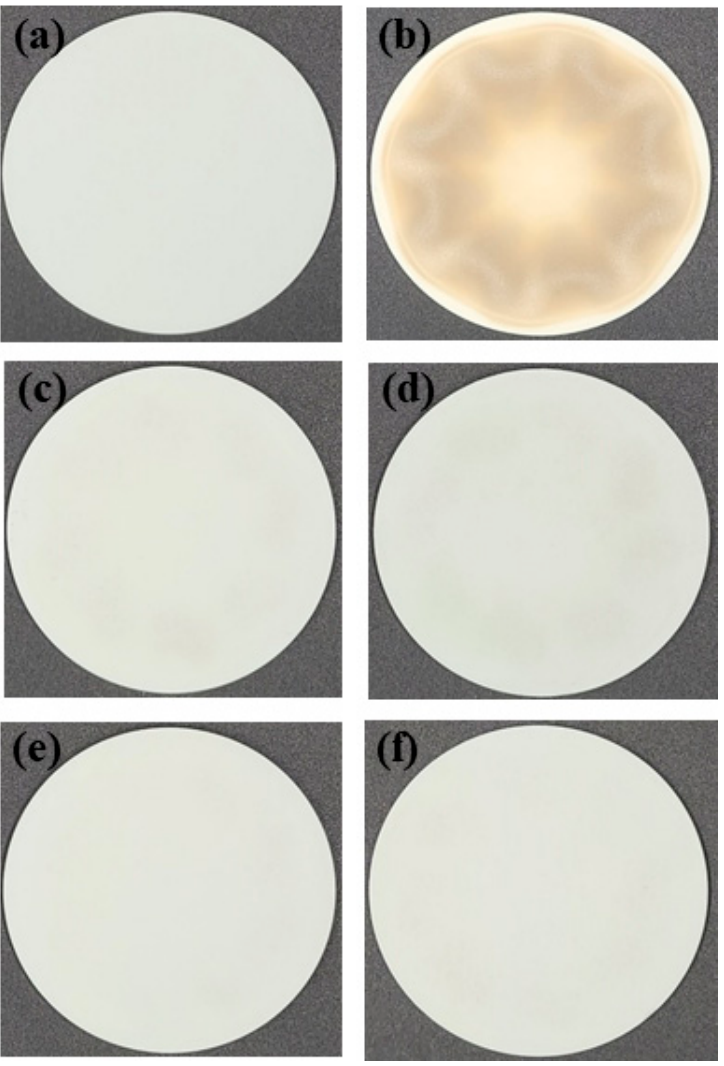
Figure 4. Surface images of APS–Y 2 O 3 coating specimens: ( a ) pristine APS–Y 2 O 3 , ( b ) APS–Y 2 O 3 plasma exposure, and after cleaning with piranha solutions prepared at ratios of ( c ) 2:1, ( d ) 3:1, ( e ) 4:1, and ( f ) 5:1.